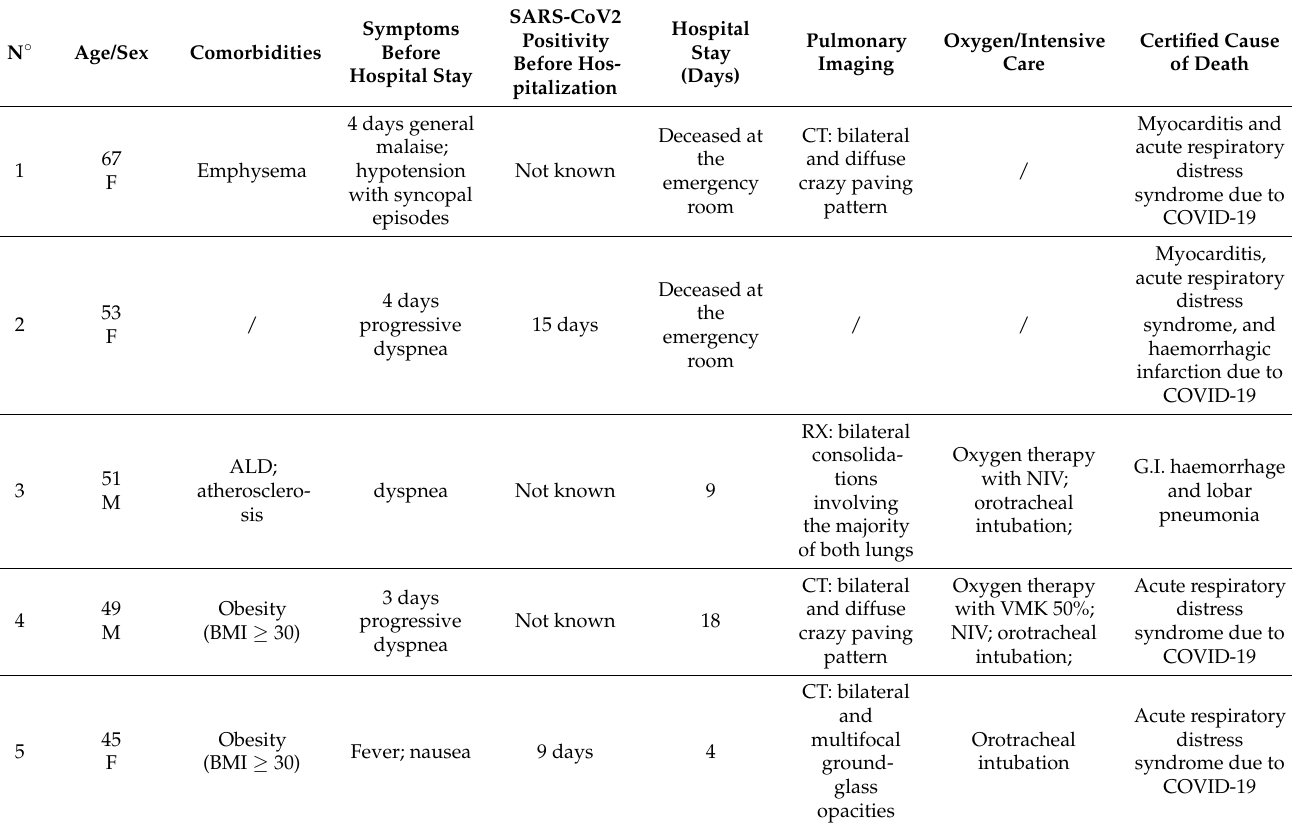
Table 2. Demographic, and clinical course of unvaccinated